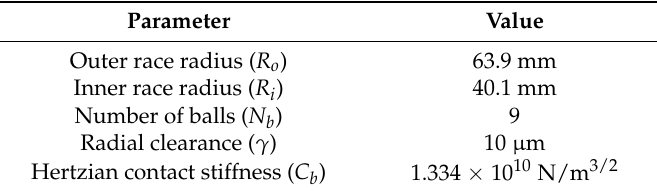
Table 3. Main parameters of the ball bearings.